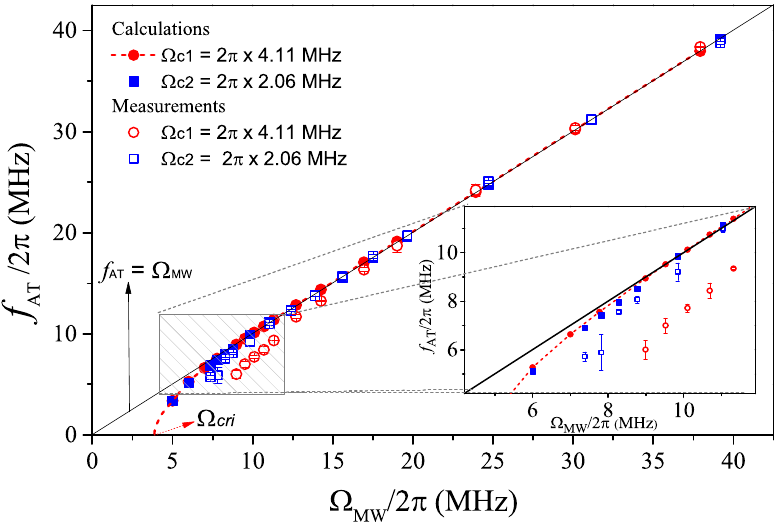
Figure 3. (color online) Measurements (hollow) and calculations (solid) of f AT as a function of microwave Rabi frequency Ω MW for the probe Rabi frequency Ω p = 2 π × 4.00 MHz and two different coupling Rabi frequency Ω c 1 = 2 π × 4.11 MHz (red circles) and Ω c 2 = 2 π × 2.06 MHz (blue squares). f AT shows linear increase as microwave field, and f AT ≈ Ω MW in a strong microwave coupling range, when Ω MW (cid:38) 2 π × 17 MHz for the case Ω c 1 and (cid:38) 2 π × 10 MHz for the case Ω c 2 ; whereas f AT < Ω MW , demonstrating the nonlinear dependence on the microwave field. Inset: a room-in of nonlinear region indicated by the gray rectangle. The black thin line indicates the reference f AT = Ω MW